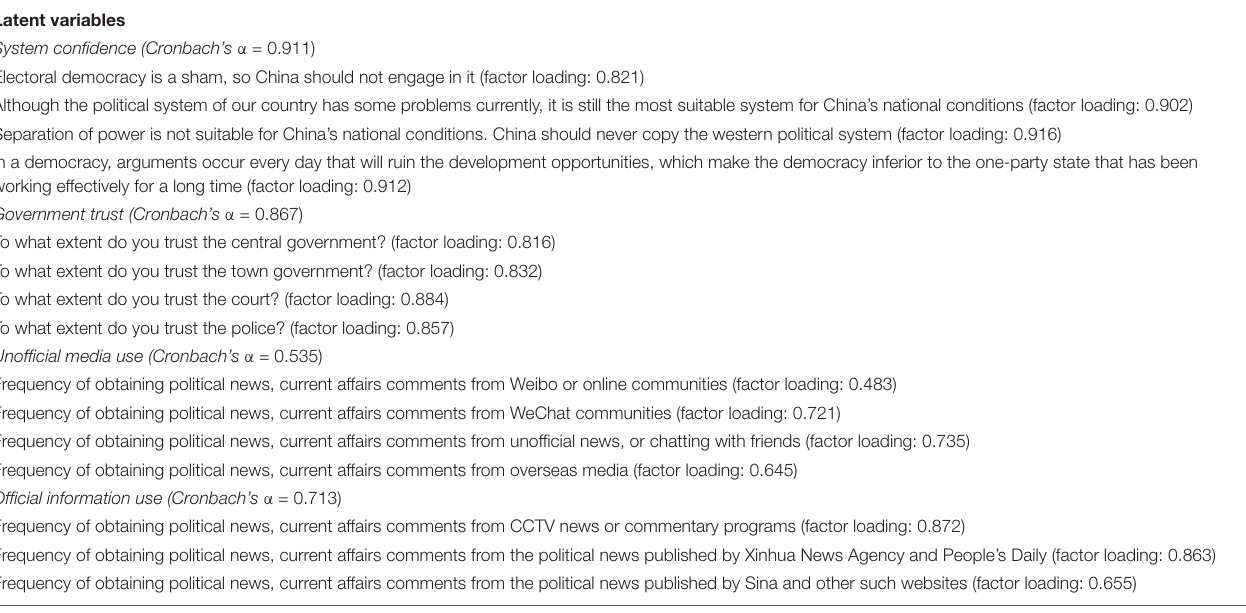
TABLE 2 | Measurements. Latent variables